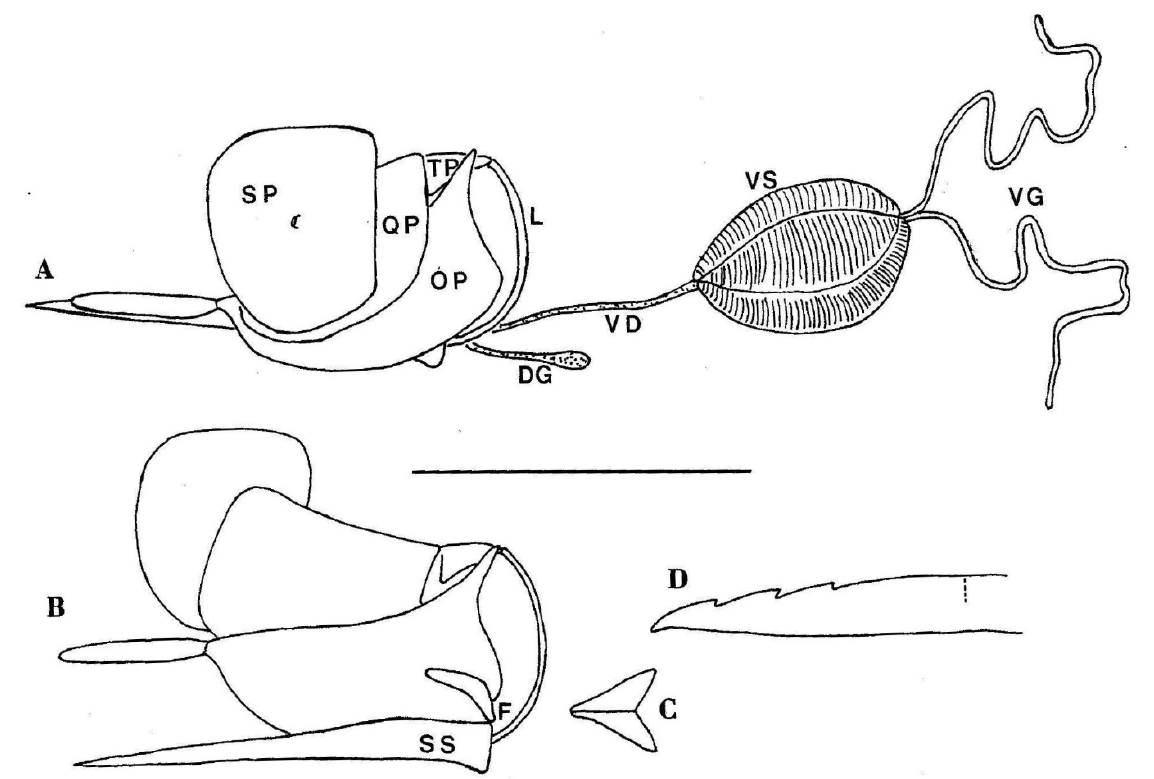
Figure 1. Venom apparatus of Ropalidia horni to show features common to the Vespidae. ( A ) Side view from the left of the intact venom apparatus with soft tissues removed except for the muscles surrounding the venom sac. ( B ) Side view from the left of the stinger, with components in place but splayed. ( C ) Furcula in top view. ( D ) Tip of a lancet. Scale bar = 1 mm for ( A – C ), approximately 0.1 mm for ( D ). DG = Dufour’s gland. F = furcula. OP = oblong plate. QP = quadrangular plate. SP = spiracular plate. SS = sting shaft. TP = triangular plate. VD = venom duct. VG = venom gland. VS = venom sac. From Macalintal and Starr [2].